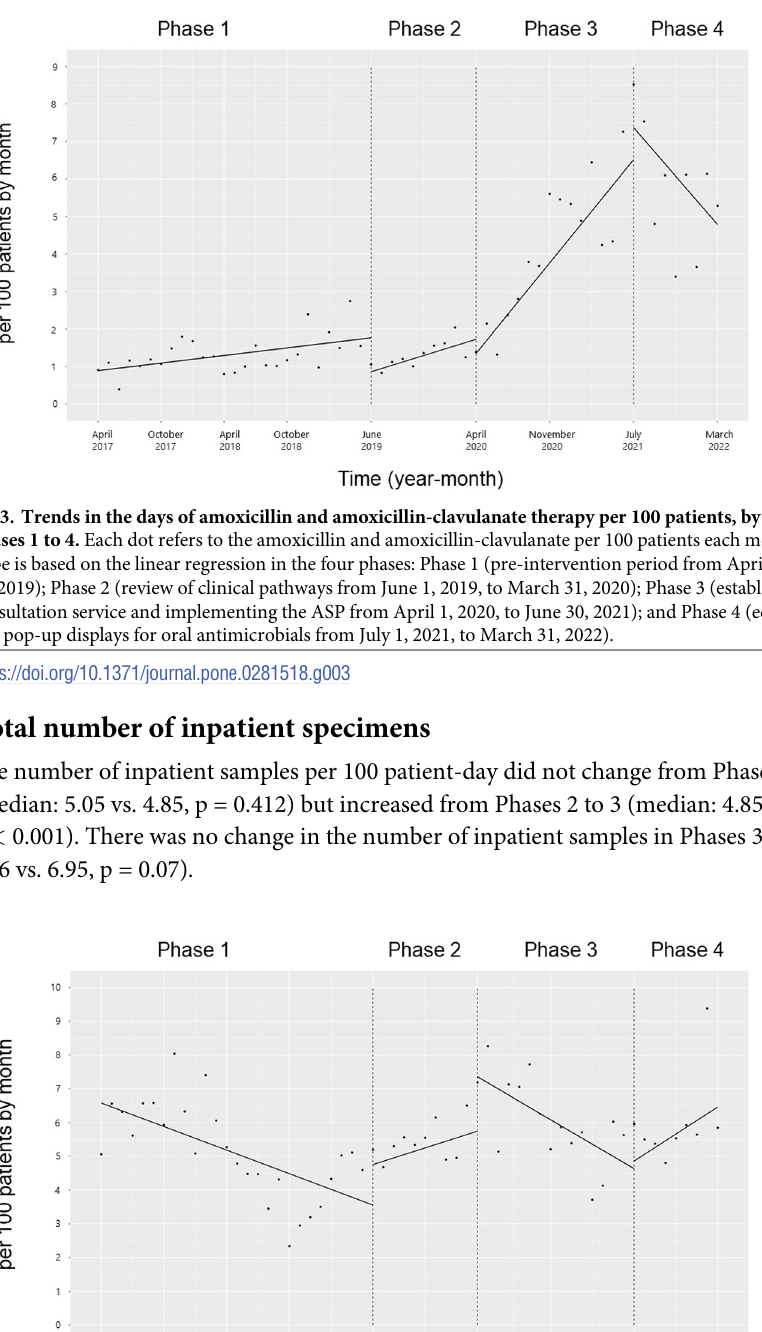
Fig 4. Trends in the days of sulfamethoxazole-trimethoprim therapy per 100 patients, by month, during Phases 1 to 4. Each dot refers to the sulfamethoxazole-trimethoprim per 100 patients each month, and the slope is based on the linear regression in the four phases: Phase 1 (pre-intervention period from April 1, 2017, to May 31, 2019); Phase 2 (review of clinical pathways from June 1, 2019, to March 31, 2020); Phase 3 (establishing an ID consultation service and implementing the ASP from April 1, 2020, to June 30, 2021); and Phase 4 (educational lecture and pop-up displays for oral antimicrobials from July 1, 2021, to March 31, 2022).